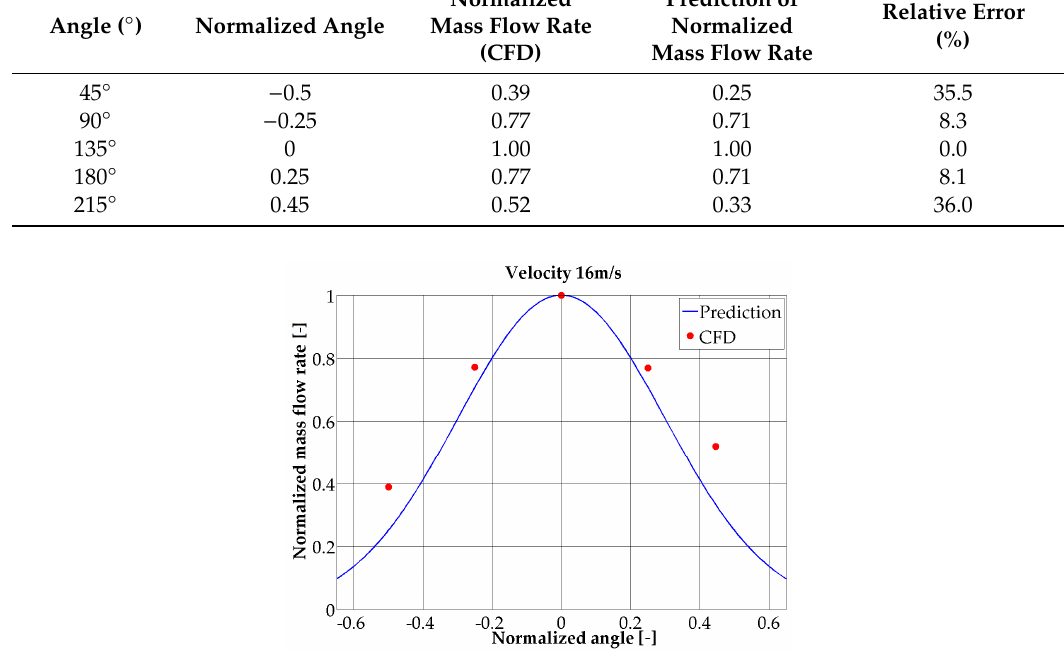
Figure 20. Comparison of normalized mass flow rate between CFD results and values derived by the function for 16 m/s wind speed.